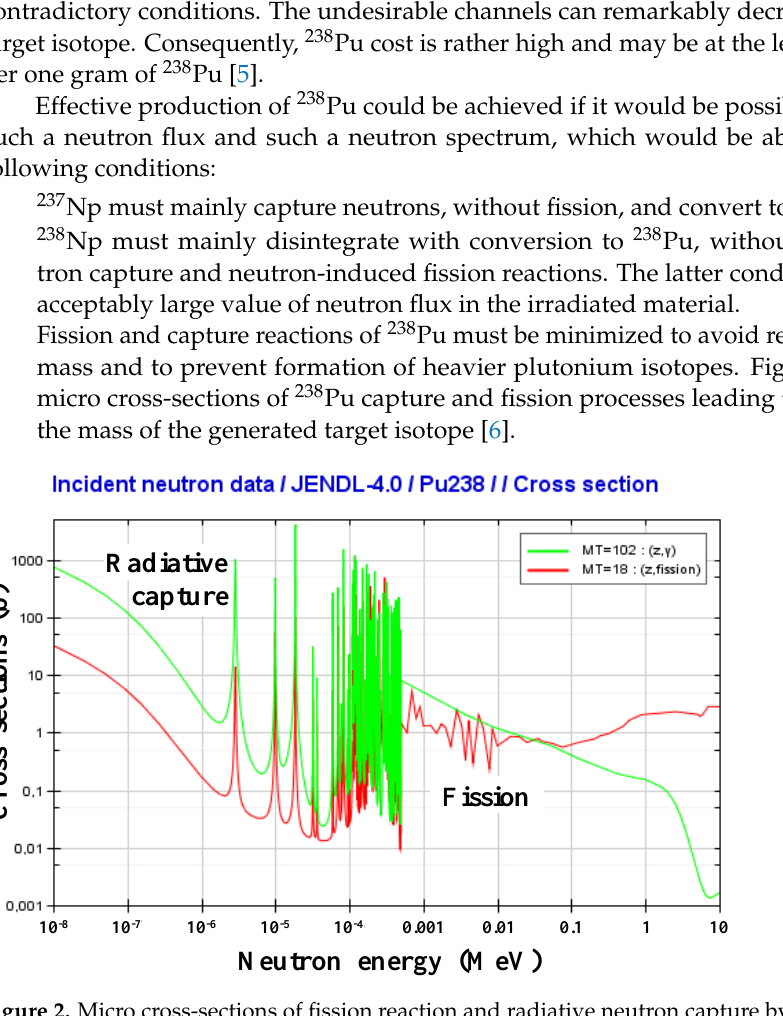
Figure 2. Micro cross-sections of fission reaction and radiative neutron capture by 238 Pu.